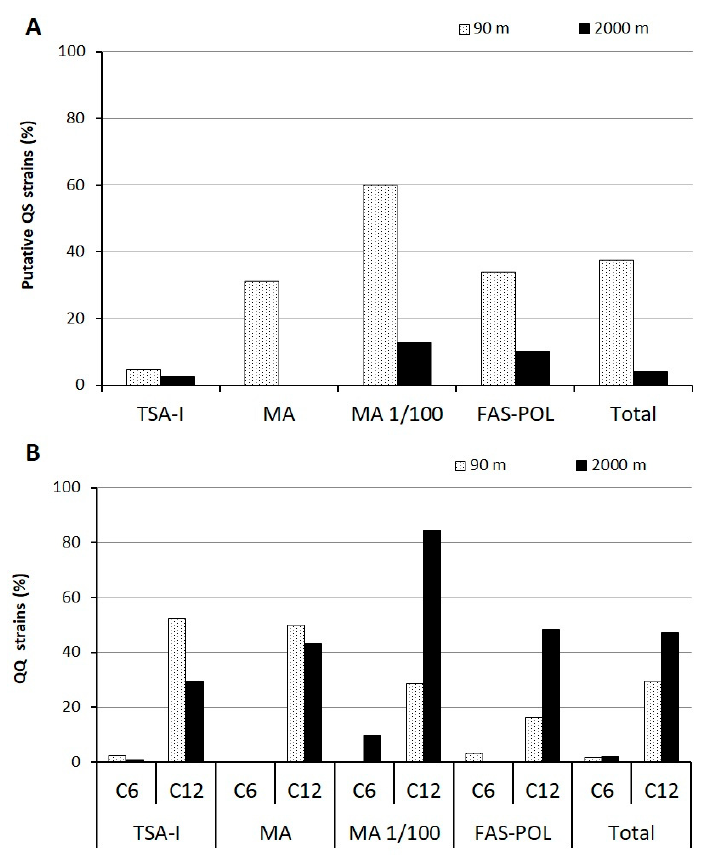
Figure 3. ( A ) Percentage of the isolated strains with the ability to activate the N -acyl homoserine lactone (AHL) sensor Agrobacterium tumefaciens NTL4 in the 90 m (white bars) and 2000 m (black bars) samples; ( B ) percentage of isolates with quorum-quenching (QQ) activity against C6 and C12-HSL isolated from each culture media in the 90 m (white bars) and 2000 m (black bars) samples, as confirmed by using the Petri dish solid assay with Chromobacterium violaceum CV026 and VIR07. Media used: tryptone soy agar 1% NaCl (TSA-1), marine agar (MA), diluted marine agar (MA 1/100), and filtered autoclaved seawater medium (FAS) supplemented with 0.5 g/L polymers: agarose, chitin and starch (FAS ‐ POL).